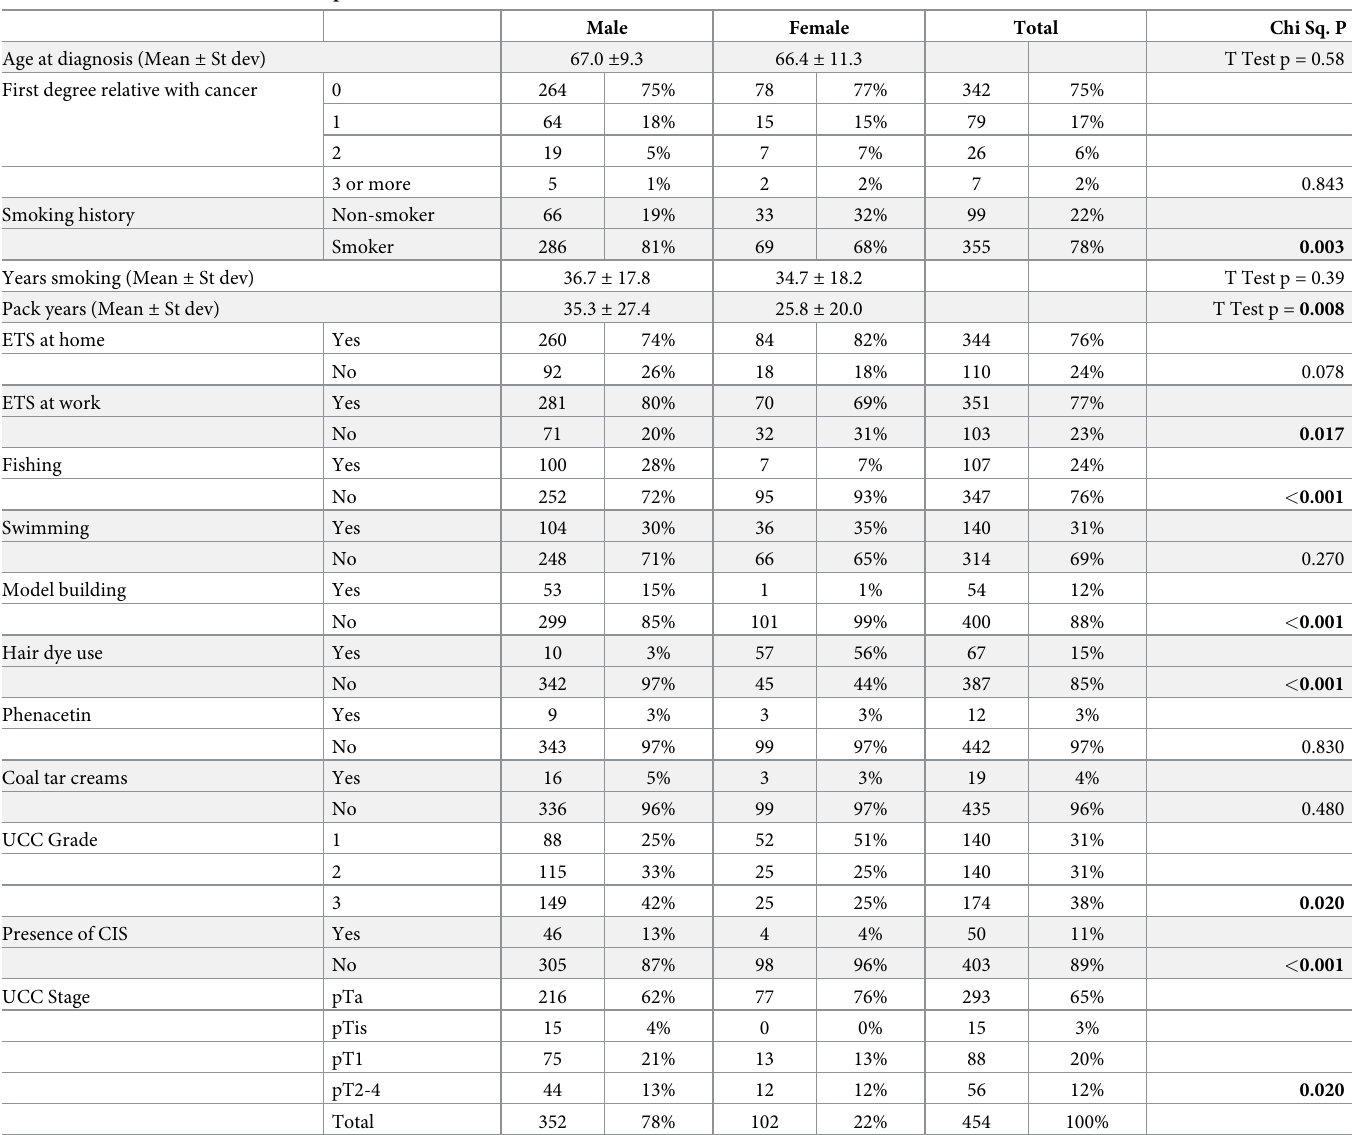
Table 1. Patients and tumours in this